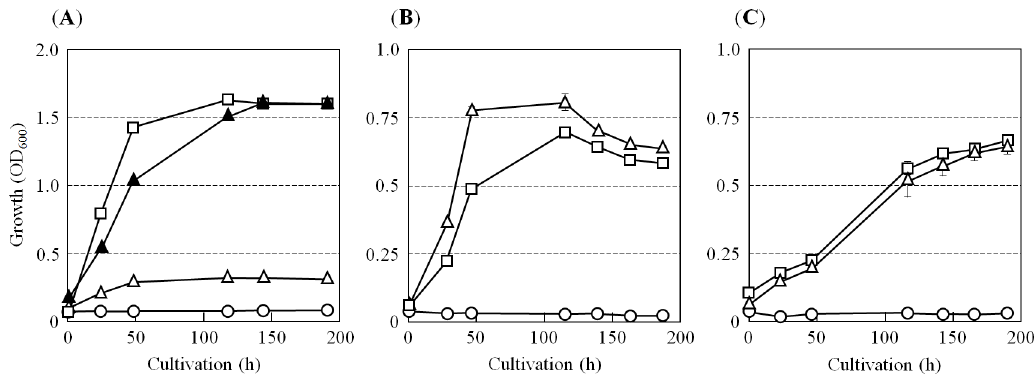
Fig 1. Aerobic growth variant phenotype of the Δ pitA variant of H . volcanii . The pitA deletionvariant of H . volcanii , strain P02 (open triangles), and the parent strain H26 (open squares)were cultivatedunder aerobicor anaerobic conditions. As indicatedin ( A ), the aerobic growth of strain P02 was strongly suppressed, and the OD 600 value reached a maximum of only approximately 0.3. Aerobicgrowth of strain P02 was restored to almost the same level of that of strain H26 by supplementation of a protoheme stock solution(dissolvedin pure DMSO) to reach 5 μ M as the final concentration to the medium (closedtriangles). The OD 600 of the medium without inoculationof the archaealcells is indicatedby opencircles in the figures. Under anaerobiccondition, strain P02 grew actively by denitrification ( B ) or by DMSO-respiration ( C ). Experiments were performed independently three times. Error bars represent standard error (S.E.). The S.E. values were small, and therefore the error bars are sometimes masked by the symbols.